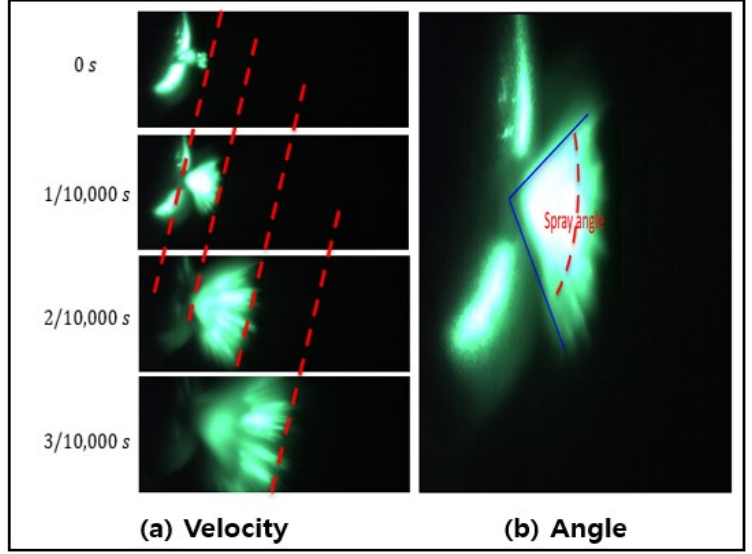
Figure 5. De fi nitions for experimental-result calculation.